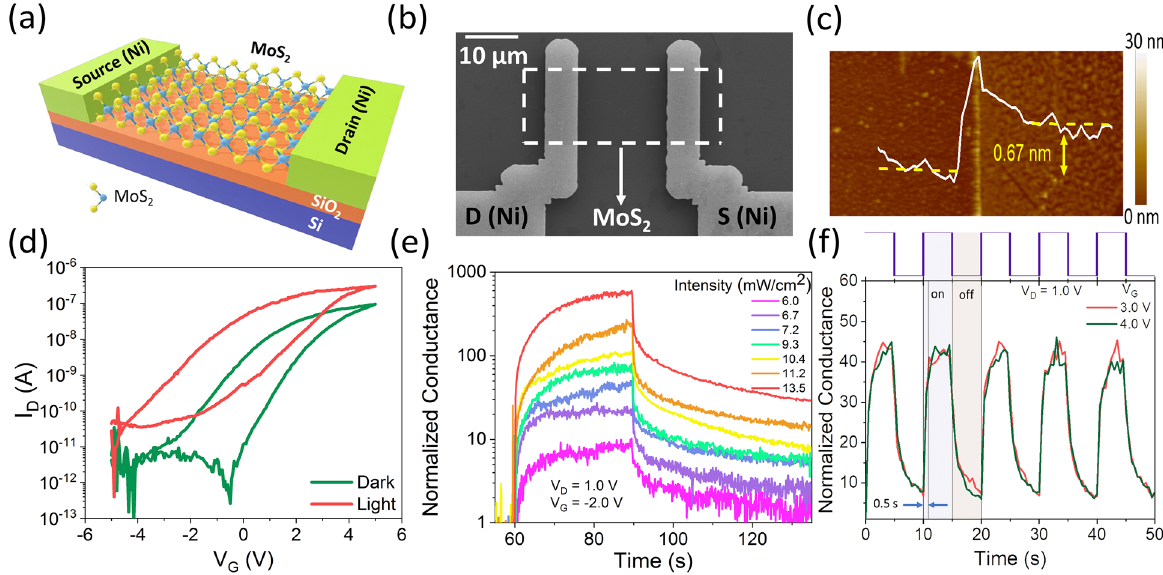
Figure 1. ( a ) Schematic diagram (not to scale) of back-gated monolayer MoS 2 FET as optoelectronic synapse. ( b ) Representative SEM image of back-gated monolayer MoS 2 FET. ( c ) AFM image of back-gated monolayer MoS 2 FET. ( d ) I D –V G at V D = 1.0 V in dark and under light illumination (wavelength 450 nm and power 35.18 mW), showing the effect of photogenerated carriers. ( e ) Transient characteristics of the device showing change in the device conductance after applying a single light pulse (pulse duration 30 s) with varying intensity at V D = 1.0 V and V G = − 2.0 V. ( f ) Photo-switching characteristics of the monolayer MoS 2 FET as photodetector at two different gate voltages under altering dark and light